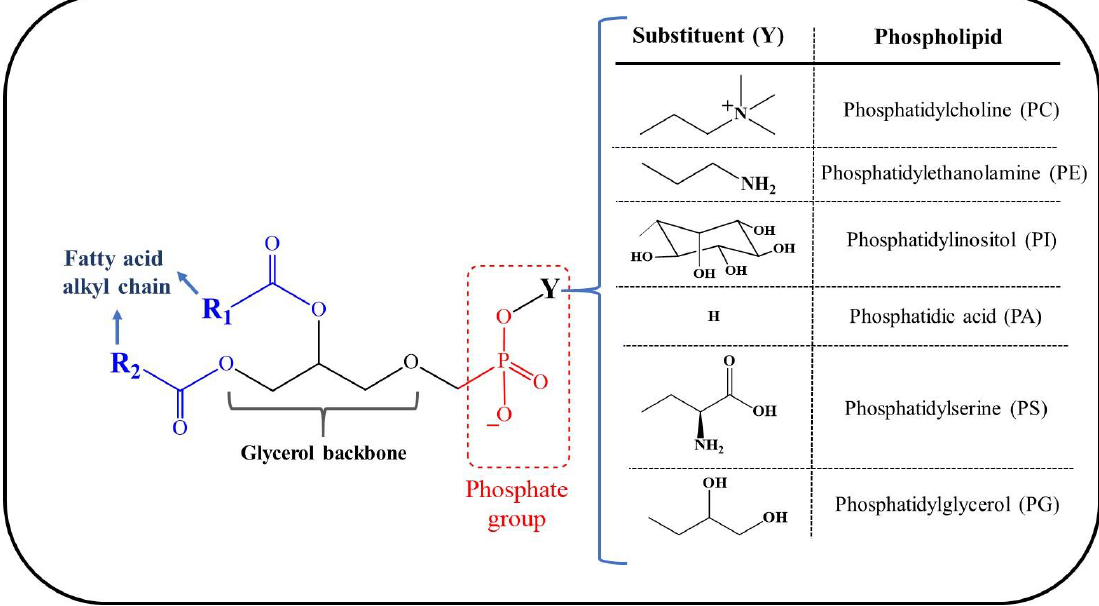
Figure1. Thechemicalstructureandclassificationofthedi ff Figure 1. The chemical structure and classification of the different types of glycerophospholipid lecithins.